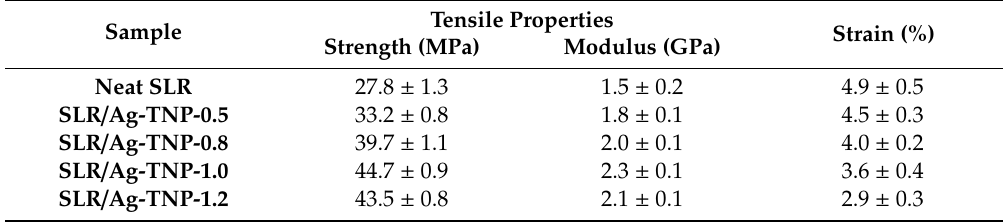
Table 1. The tensile strength and tensile modulus of SLR / Ag-TNP and neat SLR nanocomposites. Sample